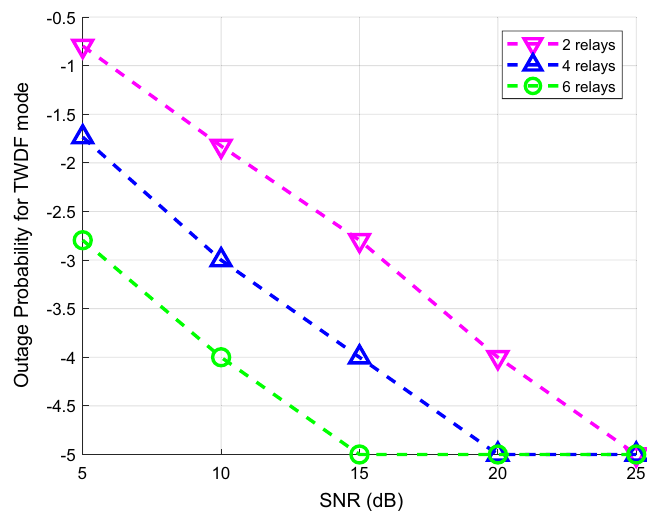
Fig. 11 Sum outage probability curve in DF relaying. It depicts the sum outage probability curve among different transmit SNRs and relays in two-way DF mode